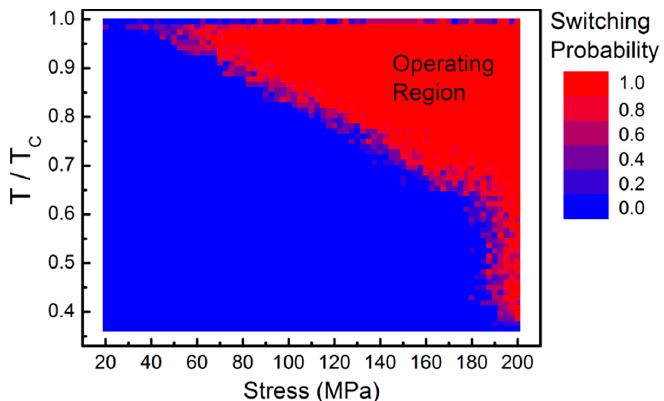
Figure 5. Switching probability as a function of temperature and stress magnitude. The probability of switching from state “1” to state “0” was computed as a function of maximum heat pulse temperature (varied by changing the laser pulse duration) from room temperature up to T C , and as a function of stress magnitude. The operating region where switching always occurs is marked.